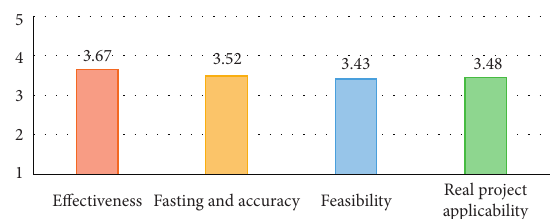
Figure 6: Evaluation of BIM-3D laser scanning compared to the conventional